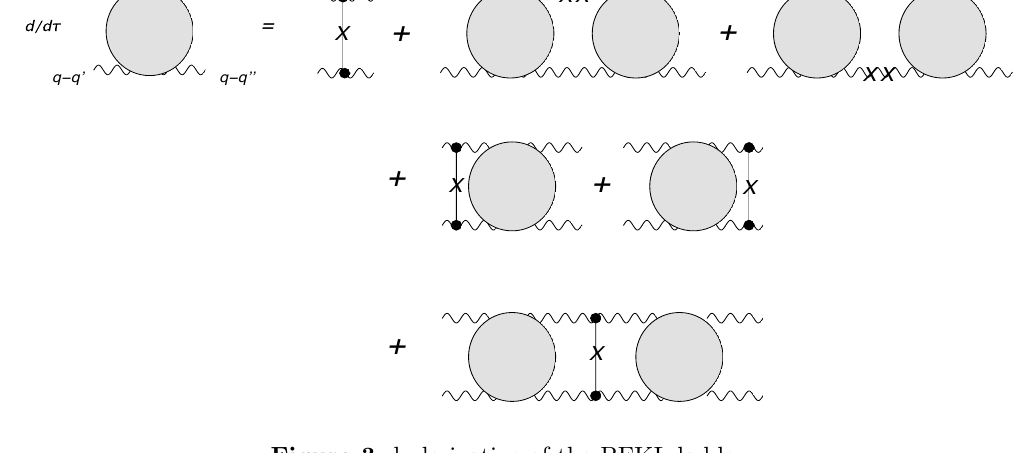
Figure 3 . k-derivative of the BFKL